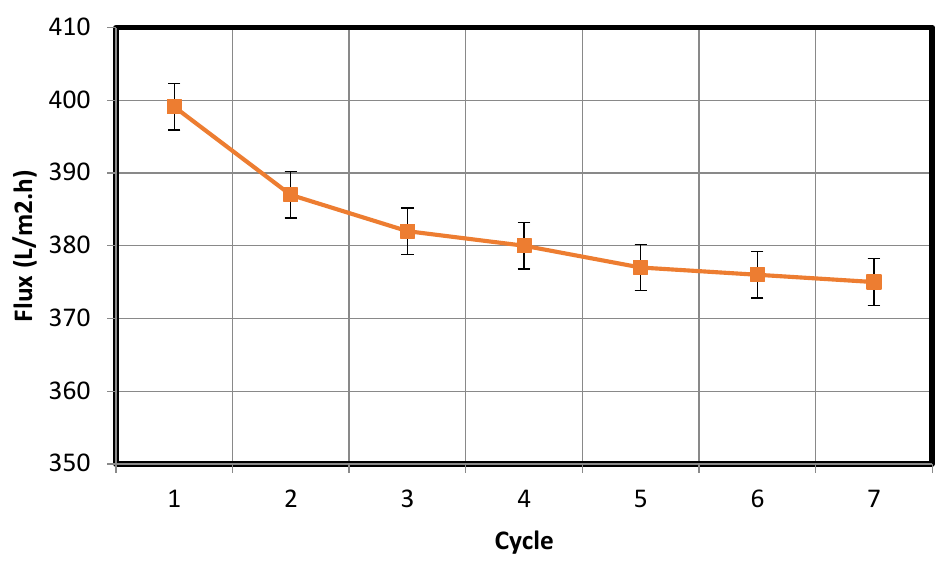
Table 2. Performance comparison of the fabricated membrane in this study with membranes in- vestigated in the literature.